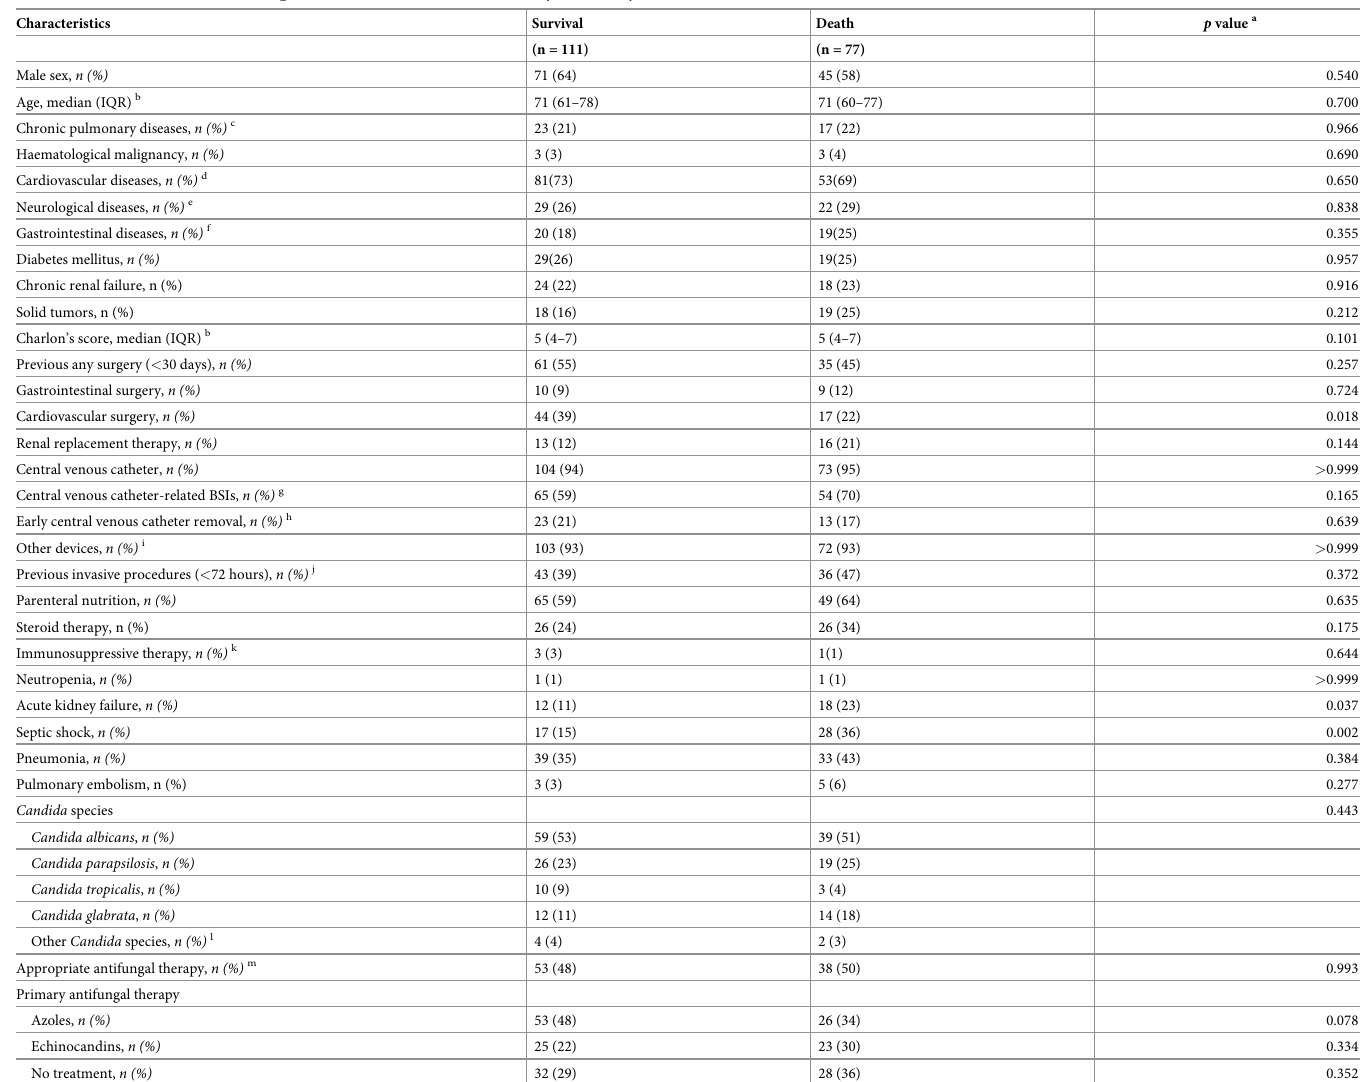
Table 3. Characteristics of ICU patients with candidemia: 30-day mortality.